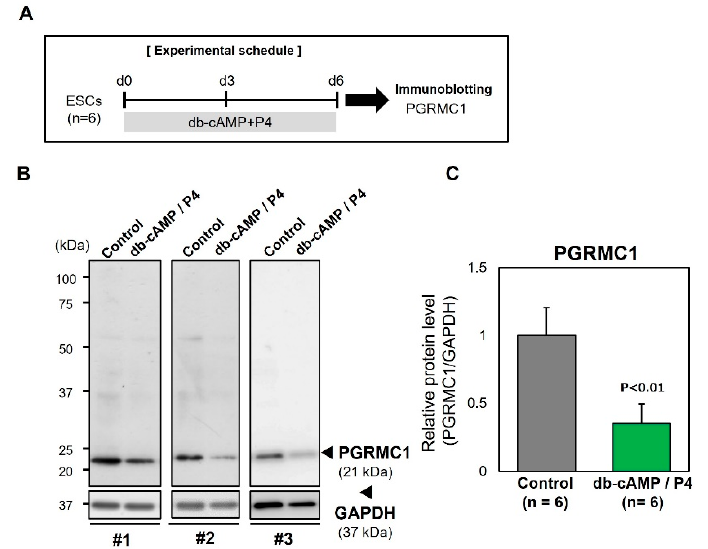
Figure 2. Expression of PGRMC1 in db-cAMP/P4-induced decidualized ESCs. ( A ) Experimental schedule. ESCs isolated from three women (#1–3) were treated without (control) or with db-cAMP (0.5 mM) and P4 (1 µM) for 6 days. ( B ) Immunoblot analysis of PGRMC1 expression. GAPDH levels served as a loading control. ( C ) Graph showing the relative levels of PGRMC1 normalized to those of GAPDH. Data are from three independent experiments.